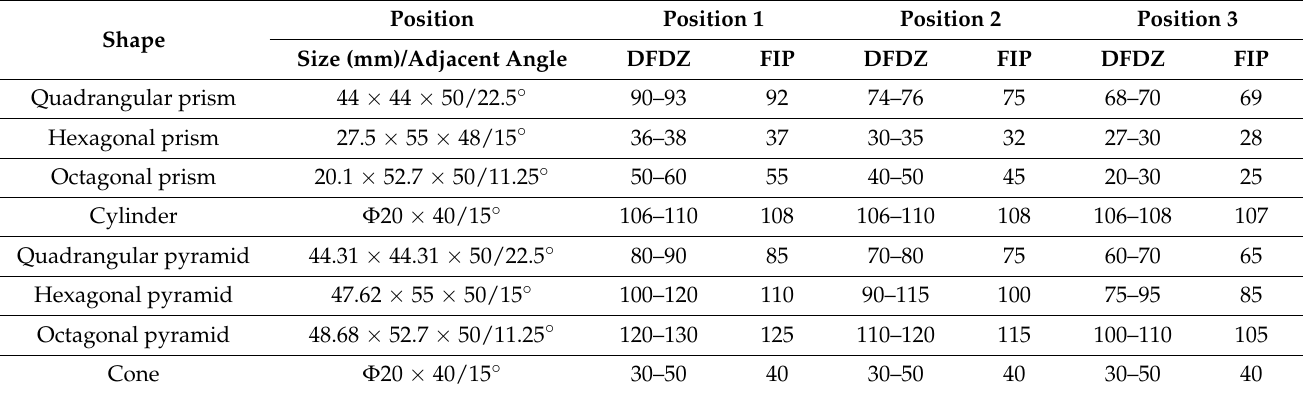
Table 3. The DFDZ and FIP for aluminum probed objects in the first three orientations.